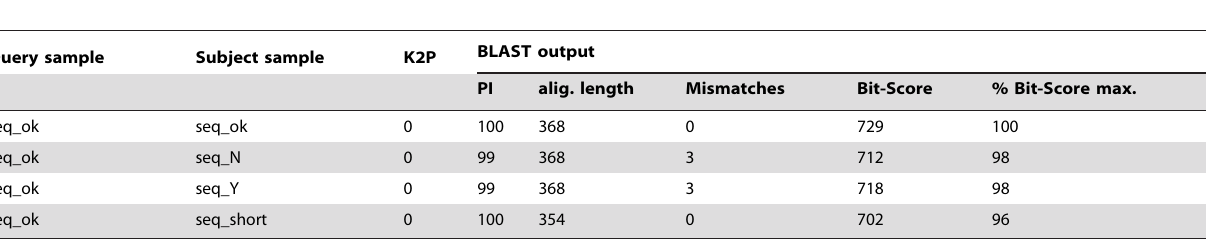
Table 5. Impact of sequence length differences, ambiguous bases or missing data on K2P distance and the output of the BLAST algorithm (Percentage Identity and